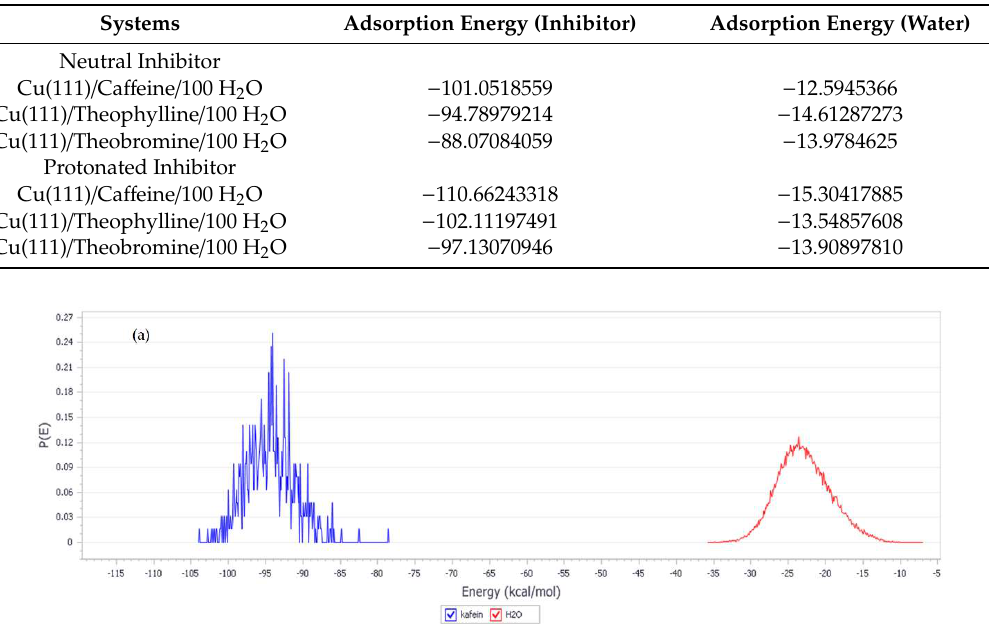
Figure 4. Adsorption energy distributions for ( a ) Cu(111)/Caffeine/100H 2 O, ( b ) Cu(111)/ Theobromine /100H 2 O, and ( c ) Cu(111)/ Theophylline /100H 2 O systems. Table